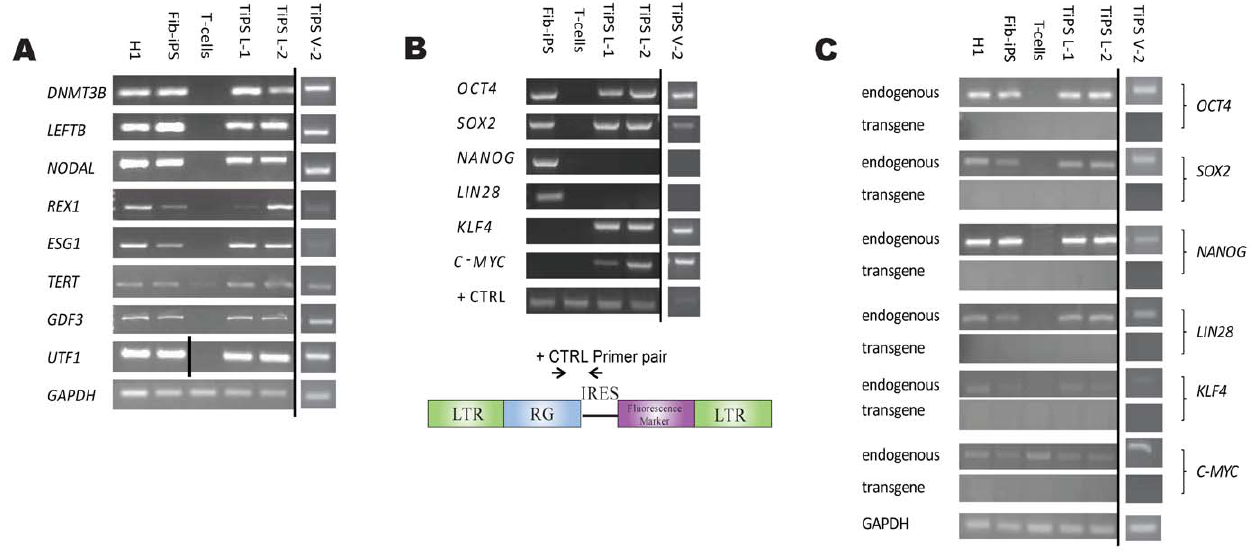
Figure 2. Derivation and characterization of induced pluripotent stem cells from human T-cells. (A) Flow cytometric analysis of input cell source CD3 surface expression. (i) CD3 surface expression on day -3 non-activated PBMCs and day 0 activated T-cells from the PBMC population in a representative donor. (ii) CD3 expression gated on the transduced (GFP + ) cell population 72 hours post-transduction in a representative donor to demonstrate preferential transduction of CD3 + cells. (iii) Histogram representation of the above metrics (i-ii) in an average of 10 donor Vacutainer- derived samples. (B) Flow cytometric analysis of hESC pluripotency markers OCT4, Tra-1-81, SSEA-3 and SSEA-4 in representative leukapheresis (‘‘TiPS L-2’’) and Vacutainer (‘‘TiPS V-1’’) derived TiPS lines. (C) T-cell receptor (TCR) b chain rearrangement analysis using multiplexed PCR primers targeted to conserved regions within the V-J region of the TCR b locus. Polyclonal starting T-cell populations are represented by a bell-shaped curve of amplicon peaks within the valid fragment size range on the electropherogram. Fibroblast (non-T-cell) iPS cells (‘‘Fib-iPS’’) lack germline rearrangement at the TCR b locus and serve as a negative control. The clonally derived TiPS lines (representative data from two leukapheresis lines and one Vacutainer line, ‘‘TiPS L-1’’, ‘‘TiPS L-2’’ and ‘‘TiPS V-2’’, respectively) show one distinct peak of defined size. DNA fragment analysis was performed on an ABI 3730 DNA analyzer.